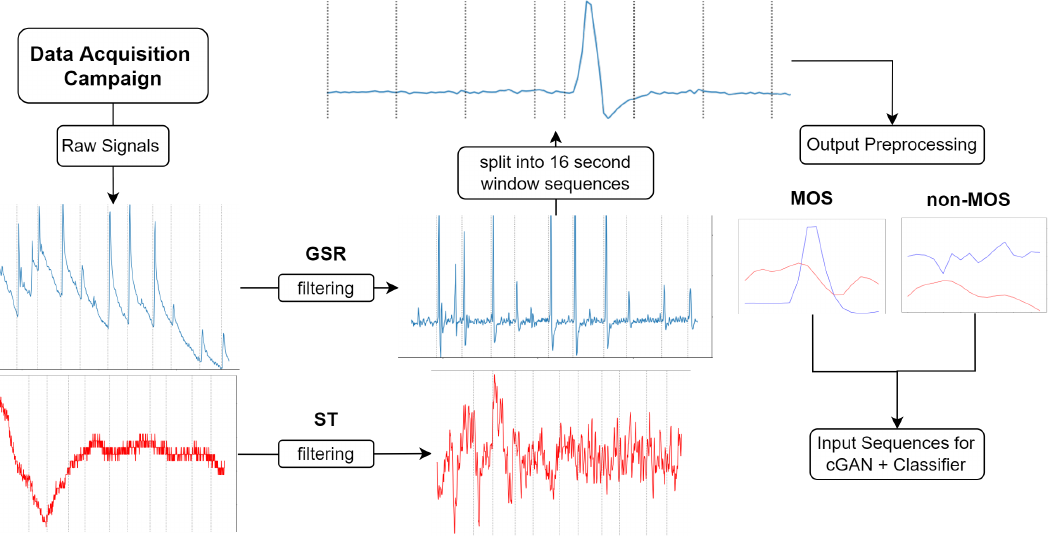
Figure 2. Prepare and preprocess raw signals for the cGAN and the stress classifier. The red line indicates ST and the blue line indicates GSR. The dotted line in the raw signals and in the filtered signals indicates induced MOS. In the window plot the dotted line indicates split